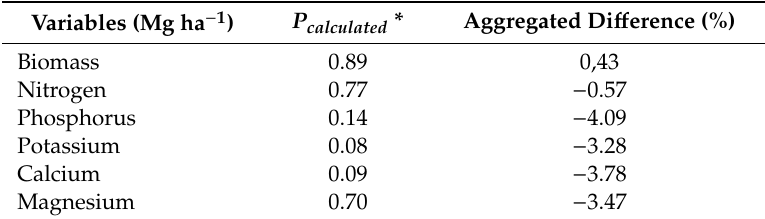
Table 11. Validation of the Schumacher–Hall model estimating biomass and nutrients in the eucalypt